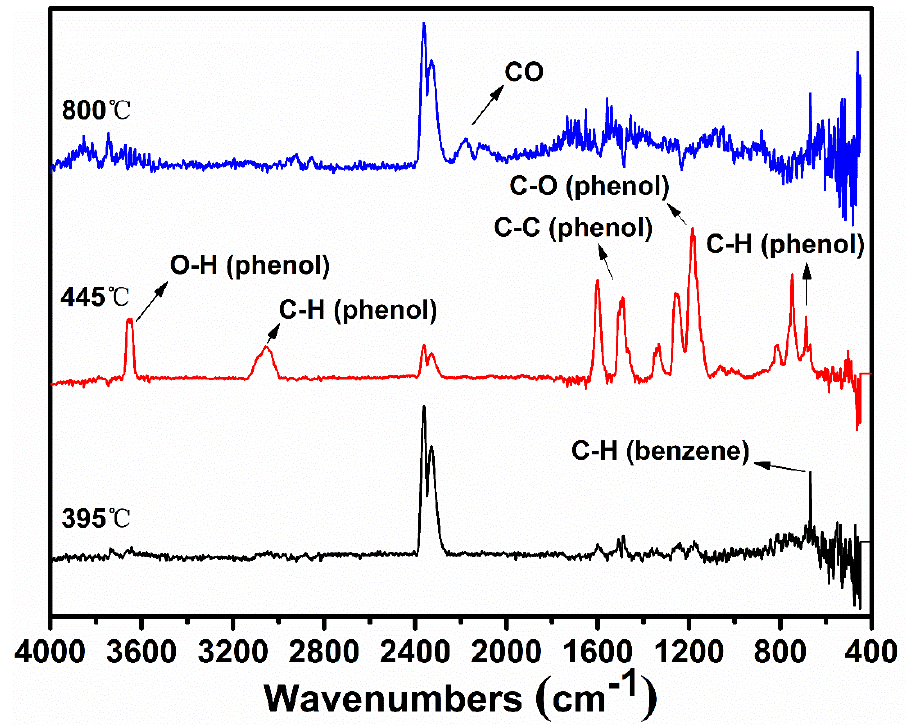
Figure 6. FTIR spectra of gaseous products of sodium p- phenoxyphenolate at selected temperatures.